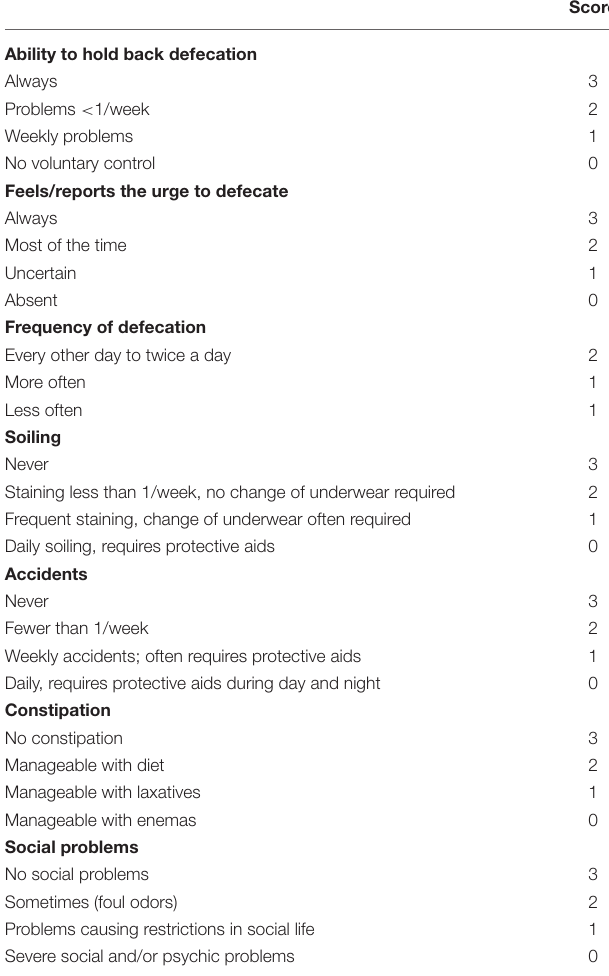
TABLE 1 | Rintala bowel function